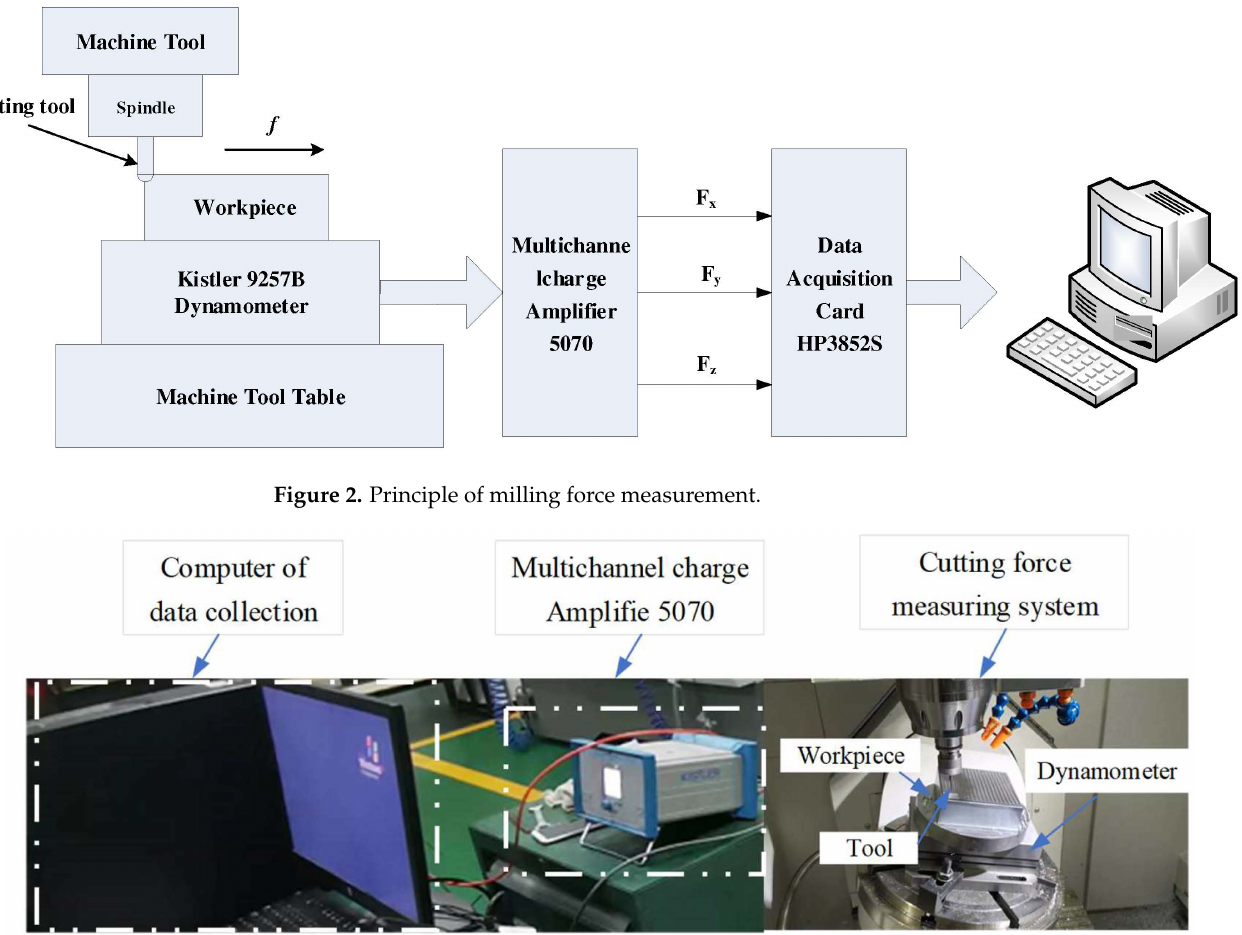
Figure 3. Experimental data